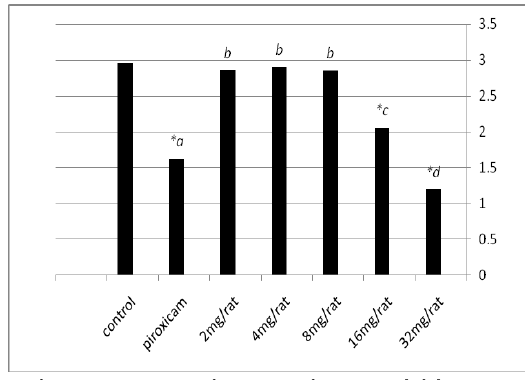
Figure 1: Mean increase in paw thickness during experimentally-induced chronic inflammation of the study